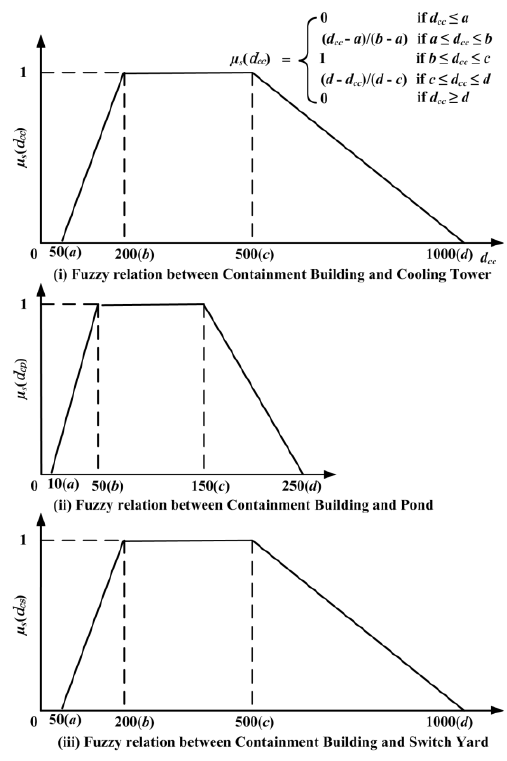
Figure 3. Trapezoidal fuzzy sets